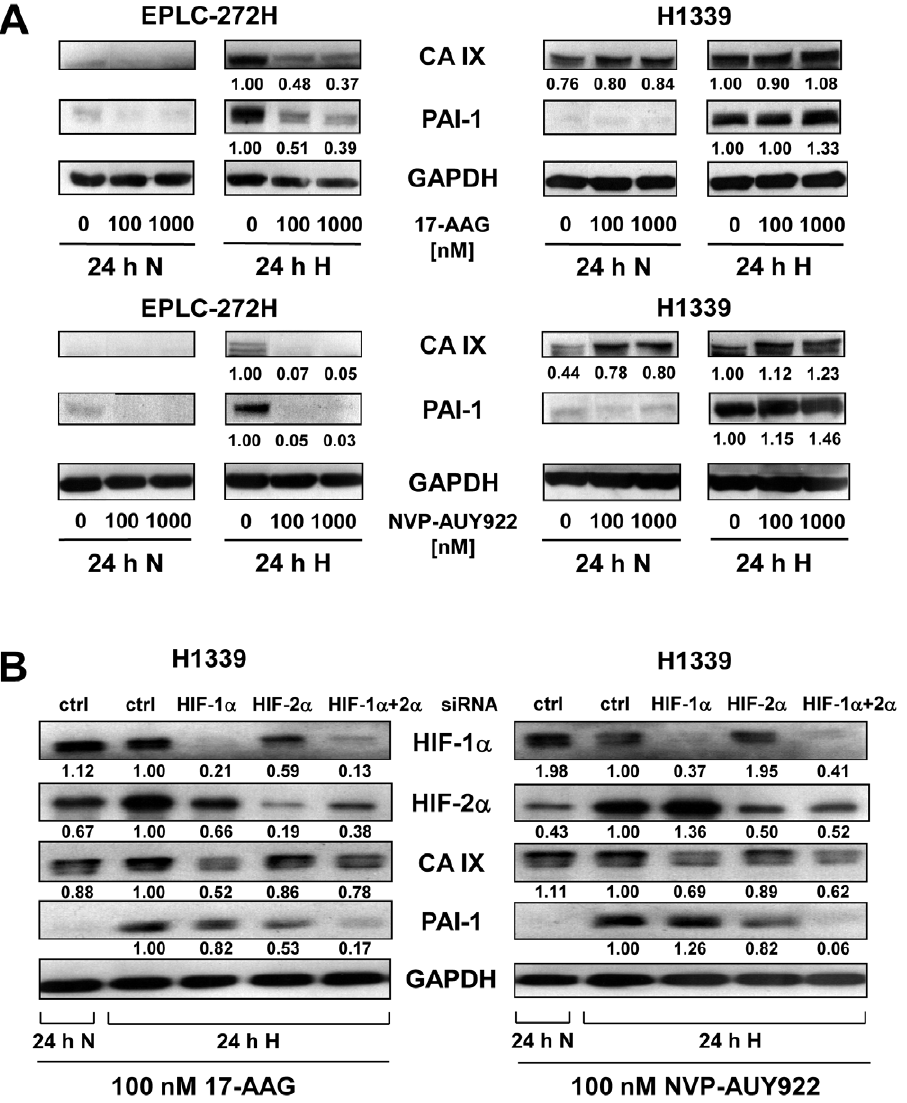
Figure 3. 17-AAG- or NVP-AUY922- induced HIF-1 a levels in H1339 lung cancer cells are functional. (A) Representative CA IX and PAI-1 immunoblots of EPLC-272H and H1339 cells treated with 0, 100 and 1000 nM 17-AAG or NVP-AUY922 and 30 min later exposed to normoxic (24 h N) or hypoxic (24 h H) conditions for 24 h. The protein bands were quantified by densitometry using ImageJ. Numbers under the lanes represent the expression of CA IX or PAI-1 relative to GAPDH. The value of 24 h hypoxia (24 h H) without drug treatment (0 nM) was set as 1 for each experiment. (B) Representative HIF-1 a , HIF-2 a , CA IX and PAI-1 immunoblots of H1339 cells transfected with a non-targeting (ctrl), HIF-1 a , HIF-2 a or both HIF-1 a and HIF-2 a siRNA. At 24 h after transfection, cells were treated with 100 nM 17-AAG or NVP-AUY922 and 30 min later exposed to normoxic (24 h N) or hypoxic (24 h H) conditions for 24 h. The protein bands were quantified by densitometry using ImageJ. Numbers under the lanes represent the expression of HIF-1 a , HIF-2 a , CA IX or PAI-1 relative to GAPDH. The value of 24 h hypoxia (24 h H) transfected with non-targeting siRNA (ctrl) was set as 1 for each experiment.